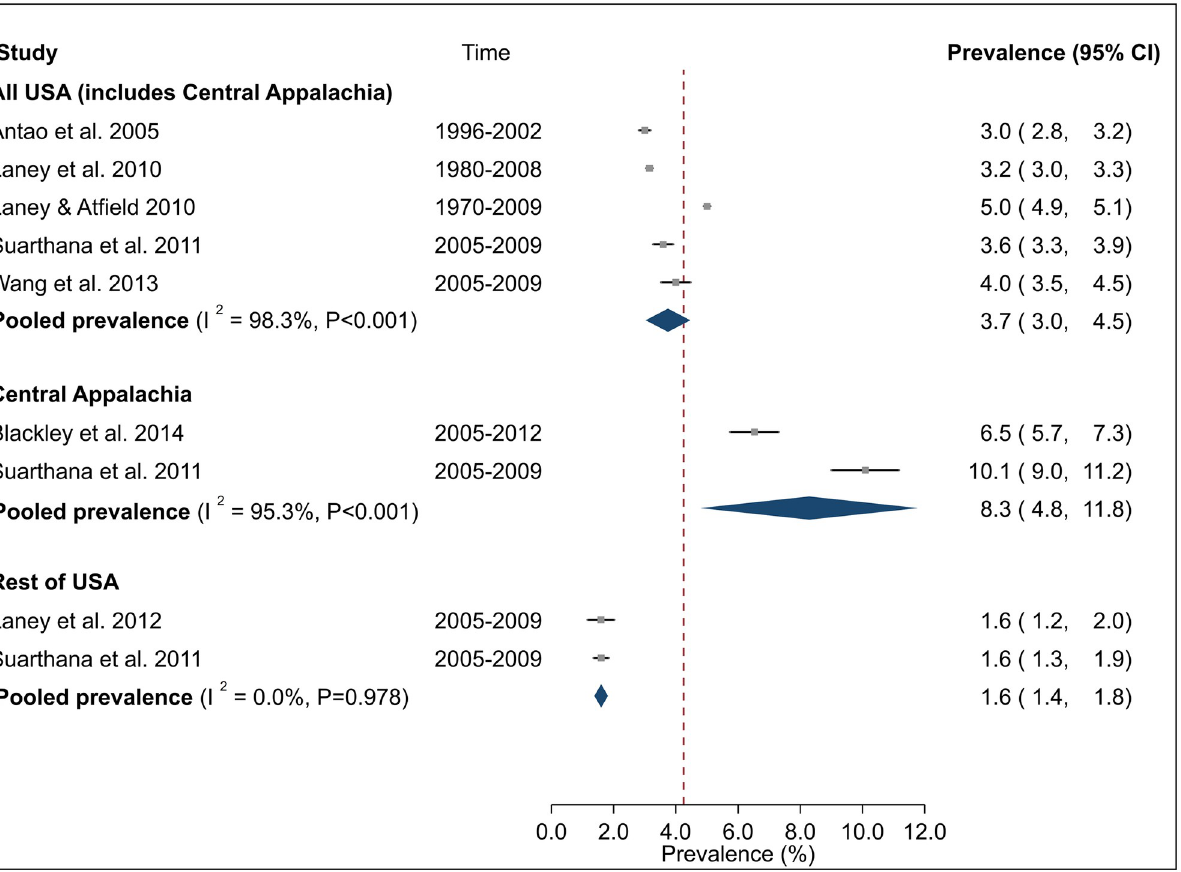
Fig 7. Forest plot from meta-analysis for overall prevalence of coal worker’s pneumoconiosis (CWP) in the United States by region: All USA, Central Appalachia and Rest of USA. The red dashed line corresponds to the overall effect size to guide the eye. The term Central Appalachia refers to the region covered by states of Kentucky, Virginia, and West